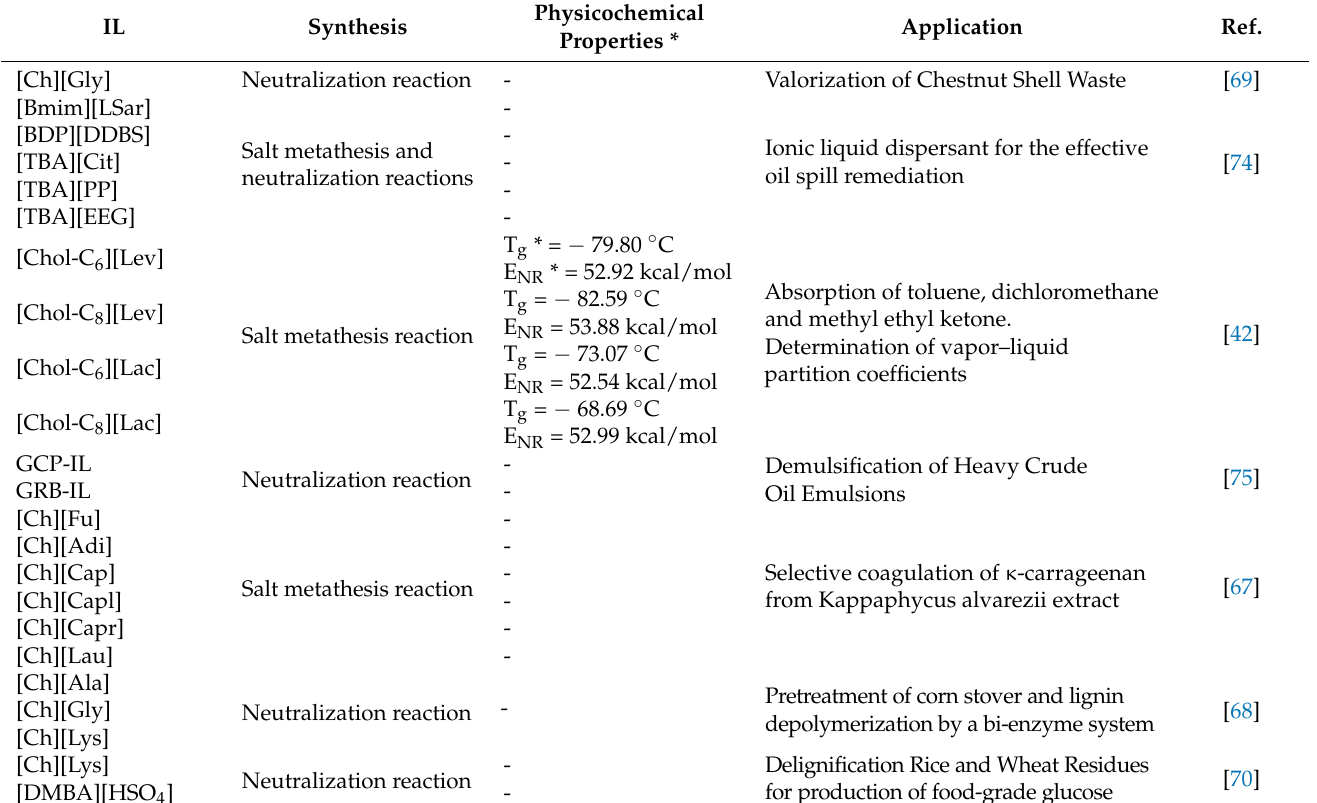
Table 4. Overview of recently investigated Bio-ILs in separation